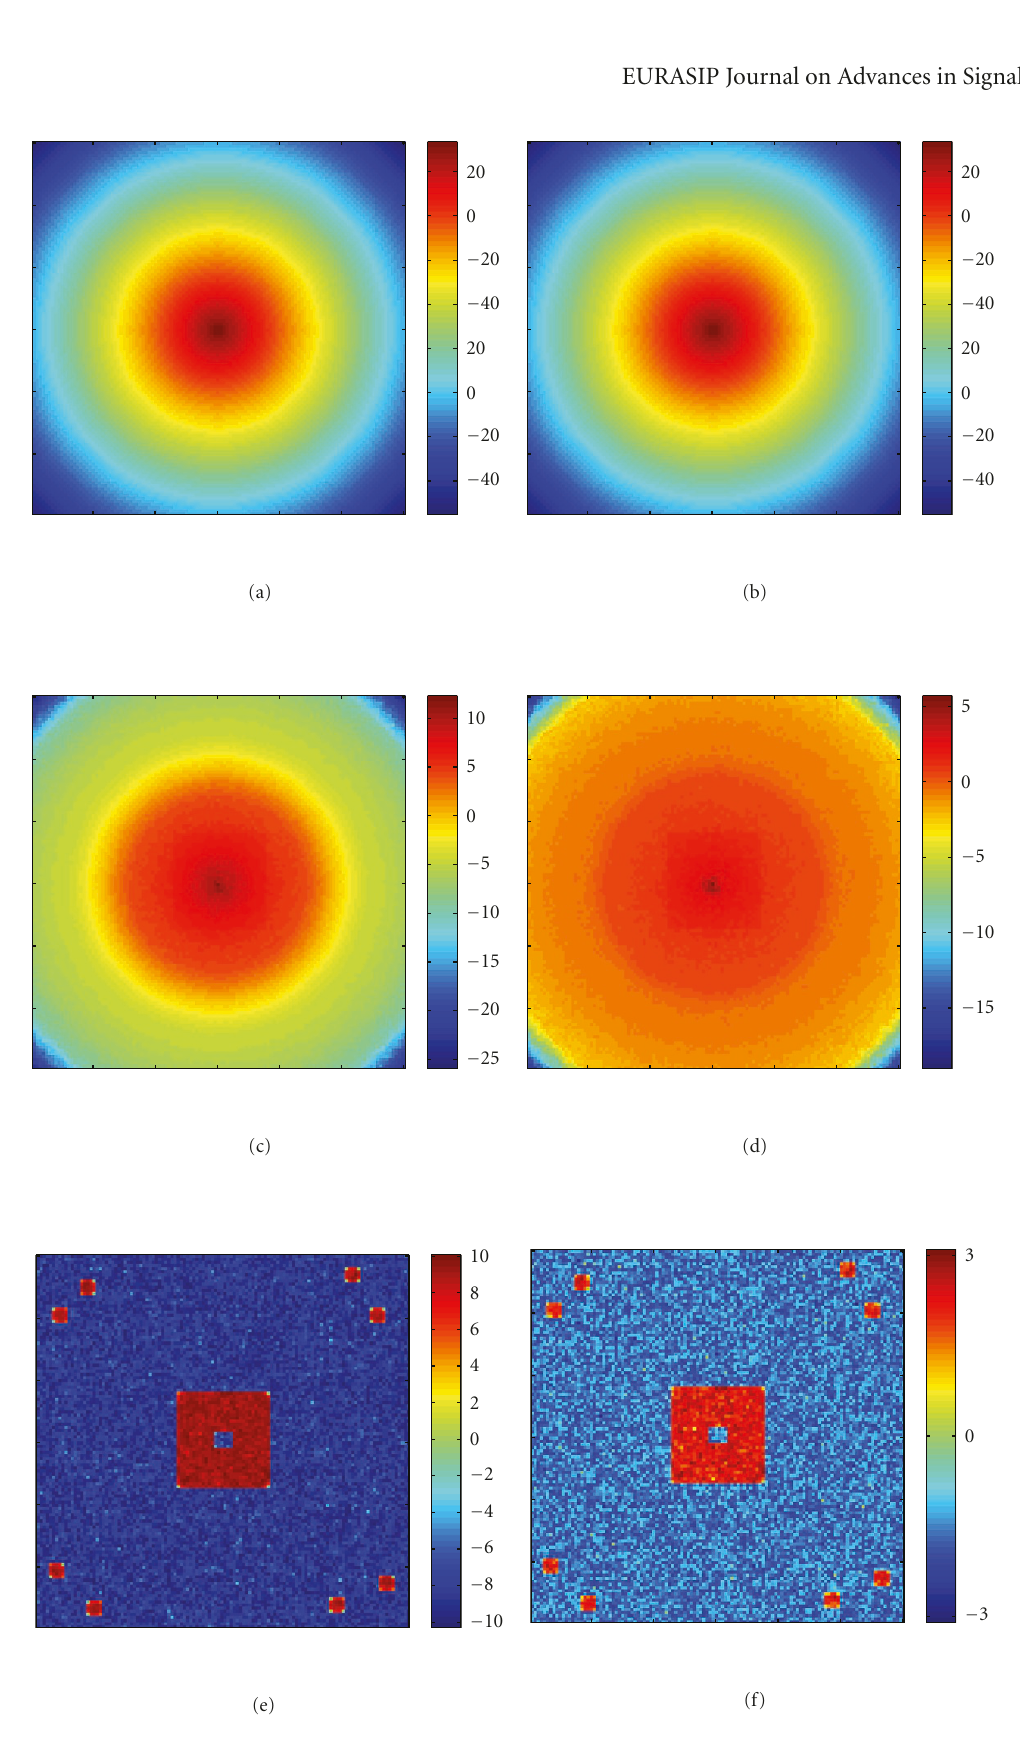
Figure 9: E ff ect of parameter α . Left column: the evolution of the φ function with α = 10. Right column: the evolution of the φ function with α = 3. (a) Initial, (c) 30 iterations, (d) final result. (b) Initial, (d) 36 iterations, (e) final